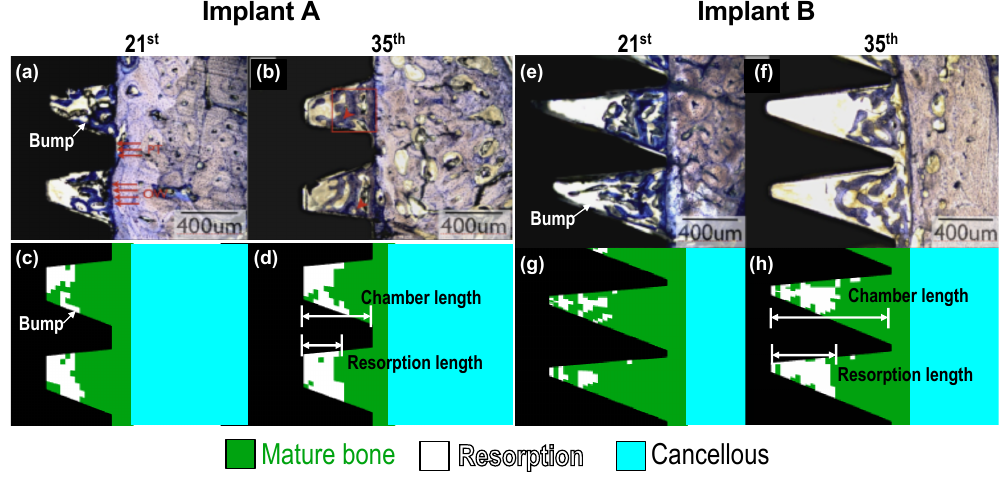
Figure 2. The wound-healing pattern around ( a , b ) implants A and ( e , f ) implant B on the 21st and 35th day observed in the animal experimental done by Marin et al. [2]. Zoom-in on the region marked in